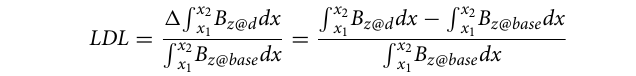
The LDL plays a role far before the distance reduces to the TP . As shown in Fig. 4(c), when the distance d increases, | LDL | decreases, but even at d > 10 mm, LDL is nonnegligible. For example, for the center-aligned